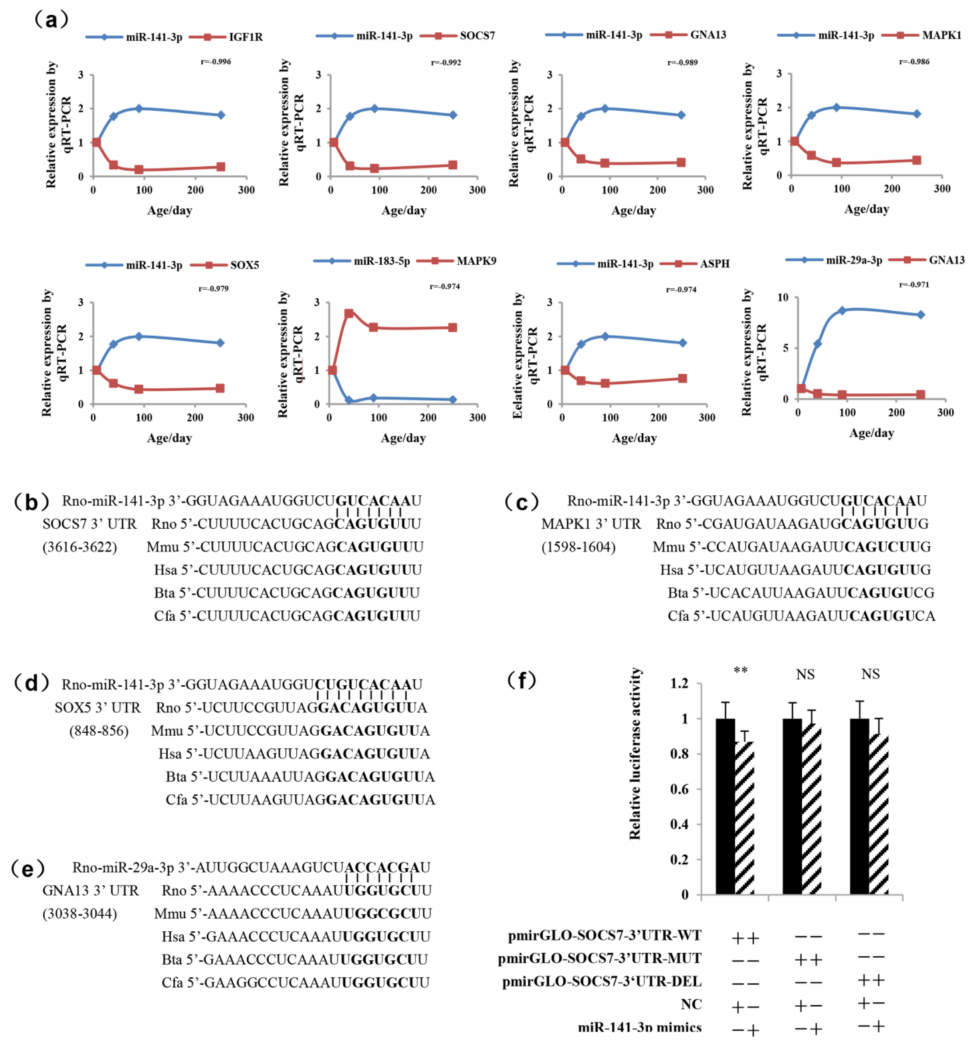
Figure 6. Temporal expression patterns and conservation analysis of negatively correlated miRNA/mRNA gene pairs. ( a ) The expression levels of the eight miRNAs/mRNA gene pairs were detected by real-time PCR. The blue curves and red curves, respectively, represent miRNAs and their predicted genes expressions. All data are represented as the mean ± SEM. A Pearson correlation coefficient ( r ) was performed to determine the correlation between the miRNAs and mRNAs. The seed regions of miR-141-3p and the seed-recognizing sites in the SOCS7 3 (cid:48) UTR ( b ), MAPK1 3 (cid:48) UTR ( c ), and SOX5 3 (cid:48) UTR ( d ) and the seed regions of miR-29a-3p and the seed-recognizing sites in the GNA13 3 (cid:48) UTR ( e ) are indicated in boldface type. All nucleotides in the seed-recognizing sites were completely conserved in several species. Rno , Rattus norvegicus ; Mmu , Mus musculus ; Hsa , Homo sapiens ; Bta , Bos taurus ; Cfa , Canis familiaris . ( f ) Relative luciferase activities were detected after the Hela cells were co-transfected with pmirGLO- SOCS7 -3 (cid:48) UTR-(WT/MUT/ DEL) plasmid and negative control (NC) or miR-141-3p mimics. Results are presented as means ± SEM ( n = 8). **, p < 0.01; NS, not significant ( p >